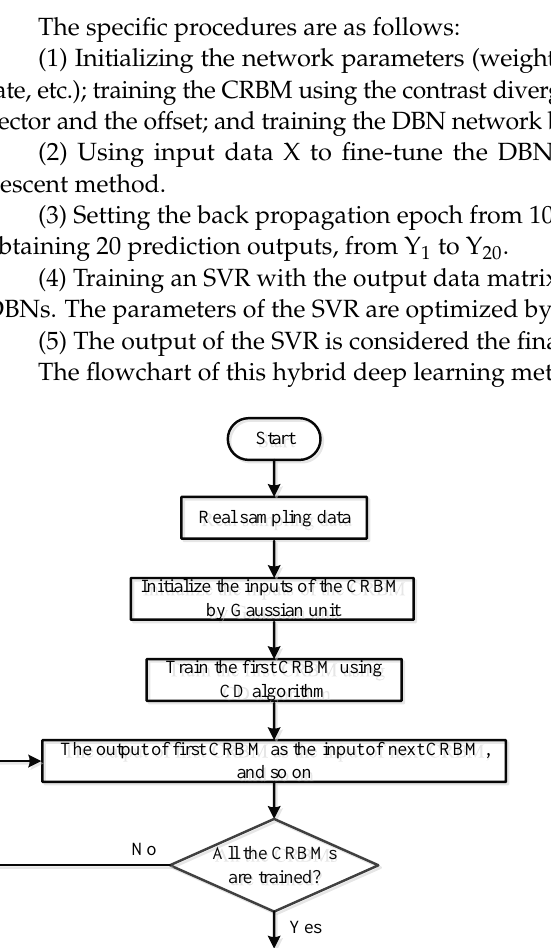
Figure 5. Structure of the proposed hybrid prediction model.